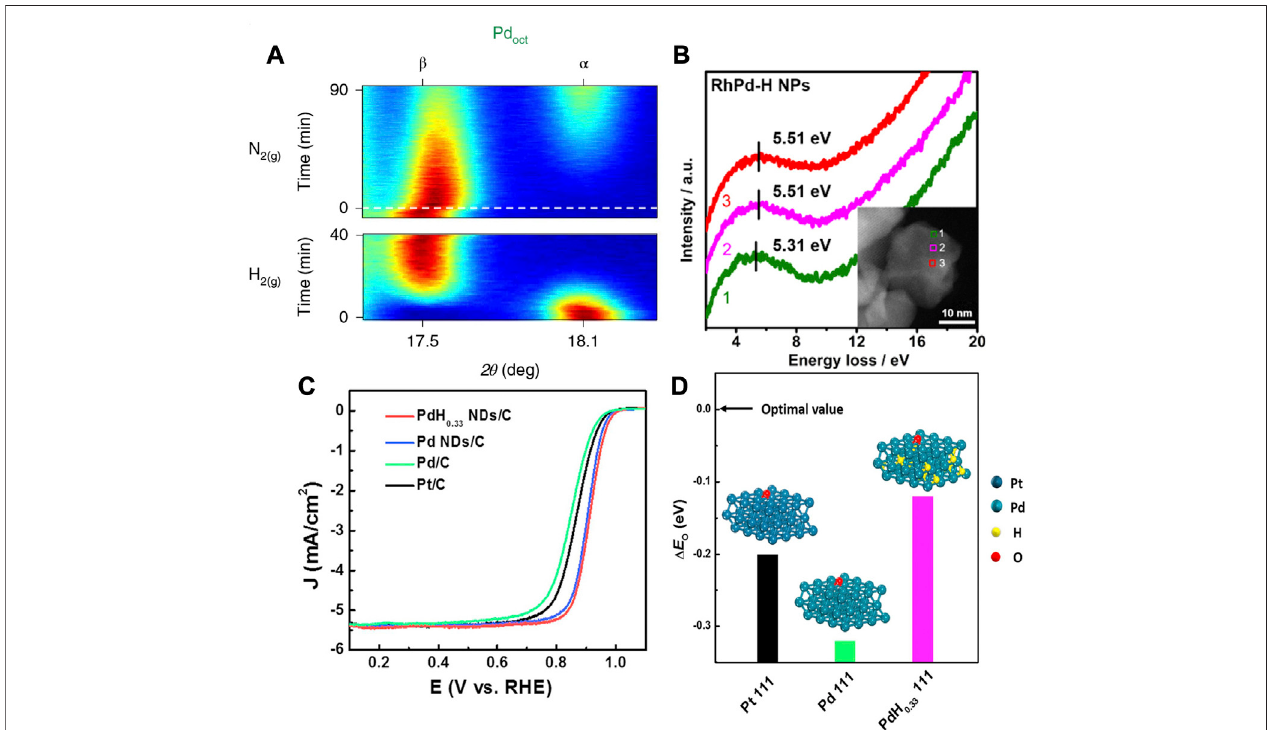
FIGURE 10 | (A) In situ XRD shows the transition between the α phase (N 2 atmosphere) and β phase (H 2 atmosphere) for PdH x octahedrons (Oct). The red represents high intensity, blue represents low intensity. (B) Electron energy loss spectra of RhPd-H nanoparticles at different positions. It veri fi es the existence of interstitial H atoms in the RhPd-H lattice. (C) Linear sweep voltammetry curve comparison of ORR activity of PtC, PdC Pd NDs/C and PdH 0.33 NDs/C in 0.1 M KOH electrolyte. (D) The surface O adsorption energy calculated by DFT based on the Pt (111), Pd (111) and PdH 0.33 (111) models. (A) Reproduced with permission (Johnson et al., 2019). Copyrights 2019. Springer Nature. (B) Reproduced with permission (Fan et al., 2019). Copyrights 2019. American Chemical Society. (C,D) Reproduced with permission (Wang et al., 2019b). Copyrights 2019.